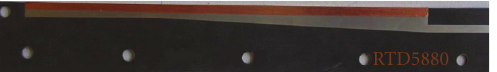
12 . 4421211109876 . 3527